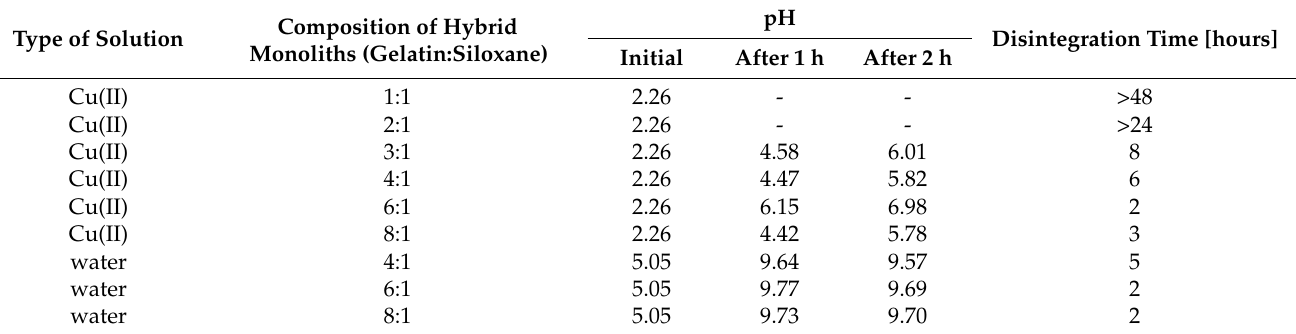
Figure 8. Photographs of the GS 2:1 hybrids after adsorption of metal ions: ( a ) copper(II), ( b ) lead(II), ( c ) cadmium(II). Table 2. The disintegration time of gelatin–siloxane monoliths.